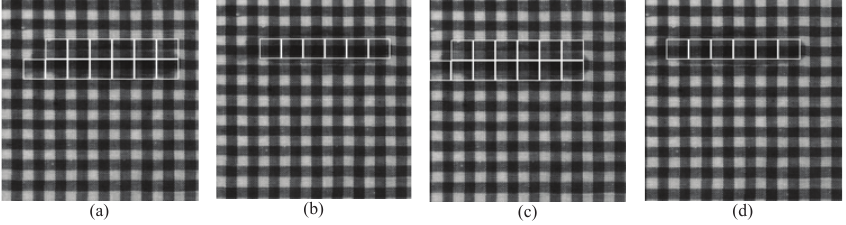
Figure 7. Defective periodic blocks identified from the cluster analysis of chi-square dissimilarity matrix derived from the cropped images obtained from (a) top-left (b) bottom-left (c) top-right and (d) bottom-right corners of the test image with their boundaries highlighted using white pixels.